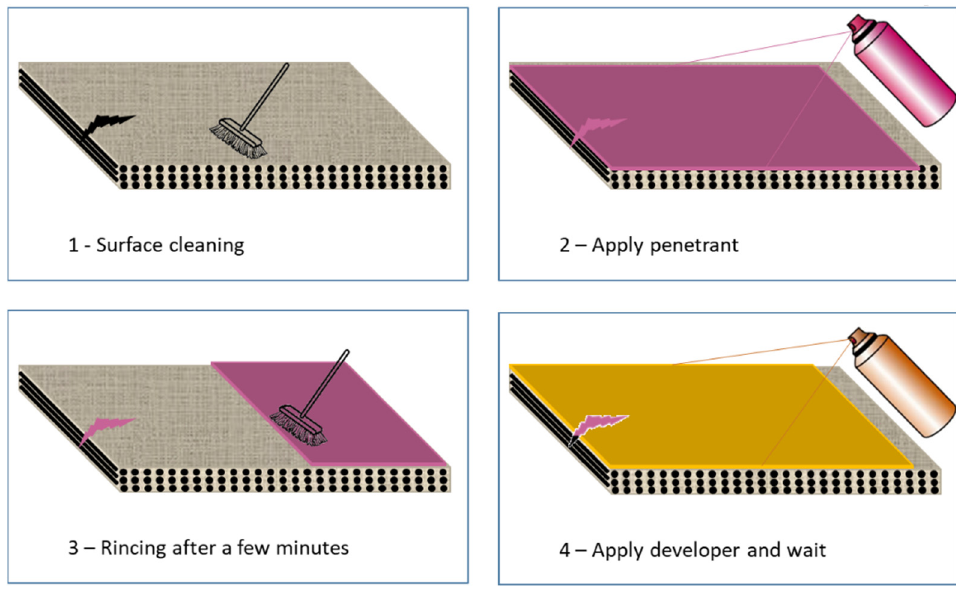
Figure 2. Principle of dye penetrant testing: (1) surface cleaning, (2) apply penetrant, (3) rincing after a few minutes, (4) apply developer and